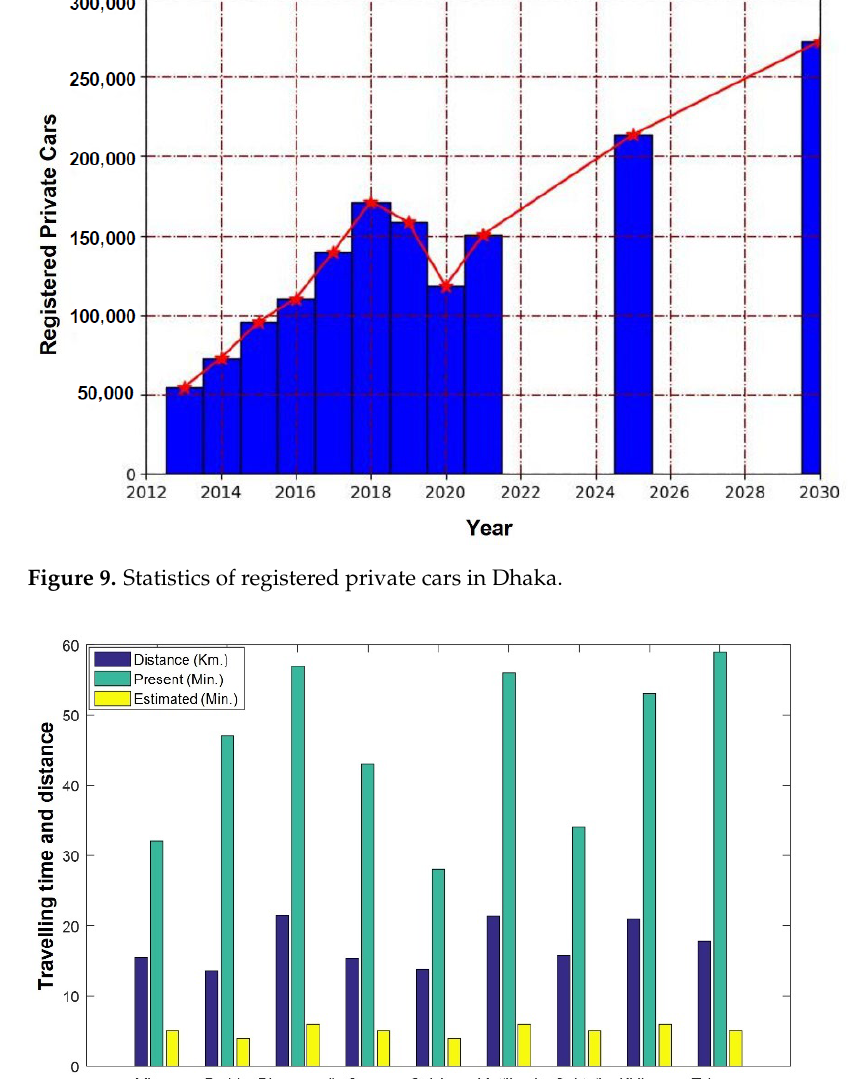
Figure 9. Statistics of registered private cars in Dhaka.